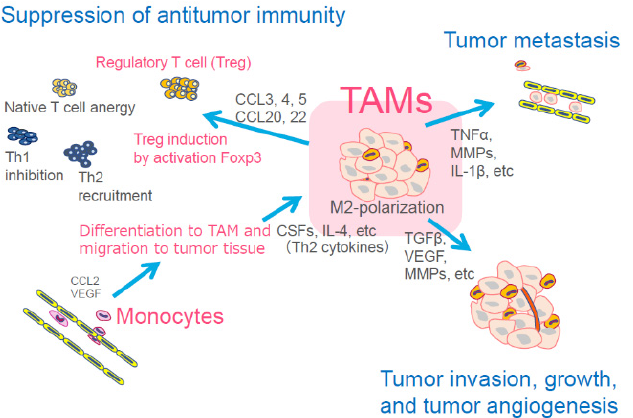
Figure 4. Main function of tumor-associated macrophages (TAMs) for cancer cells. TAMs are differ- entiated from monocytes and migrate to the tumor tissue. TAMs then accelerate tumor metastasis, tumor invasion, tumor growth, and angiogenesis. TAMs also induce suppression of antitumor immunity through induction and activation of regulatory T cells (Treg). CCL: chemokine (C-C motif) ligand, TNF: tumor necrosis factor, MMPs: matrix metalloproteinase, IL: interleukin, CSFs: colony-stimulating factors, TGF β : transforming growth factor beta, VEGF: vascular endothelial growth factor.